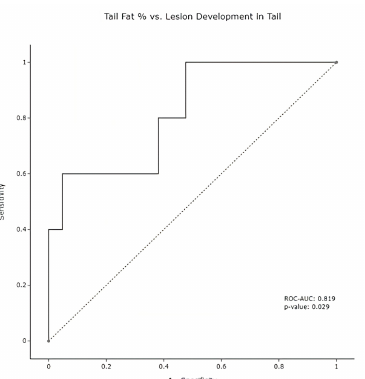
Figure 3. Pancreas Tail ROC Curve. Tail pancreatic fat measurements in subjects ( n = 26) using only the pancreatic tail fat percentage as a feature; a classifier with an ROC-AUC of 0.819 was noted ( p = 0.029).